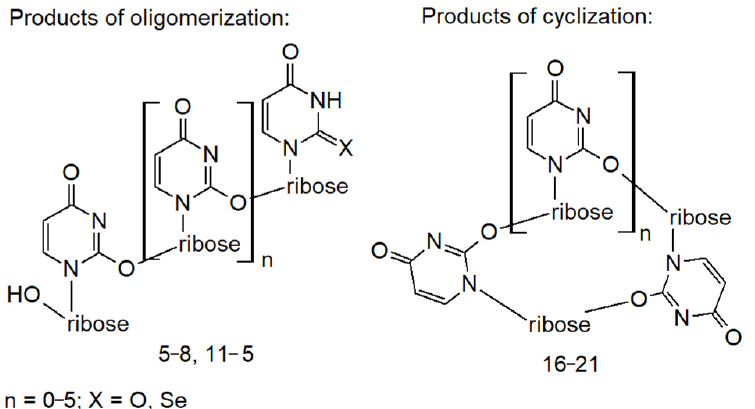
Figure 8. Structure of the oligomerization products 5 – 8 and 11 – 15 and their cyclized forms 16 – 21 .